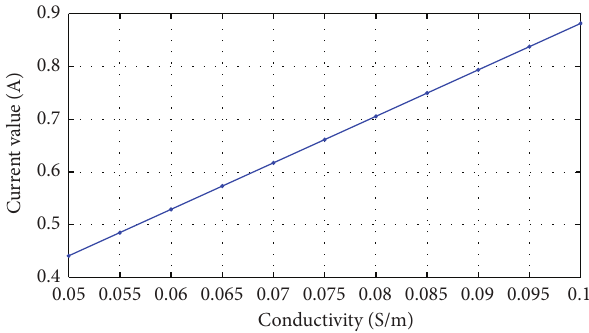
Figure 14: Curve of the maximum current value with the conduc- tivity.